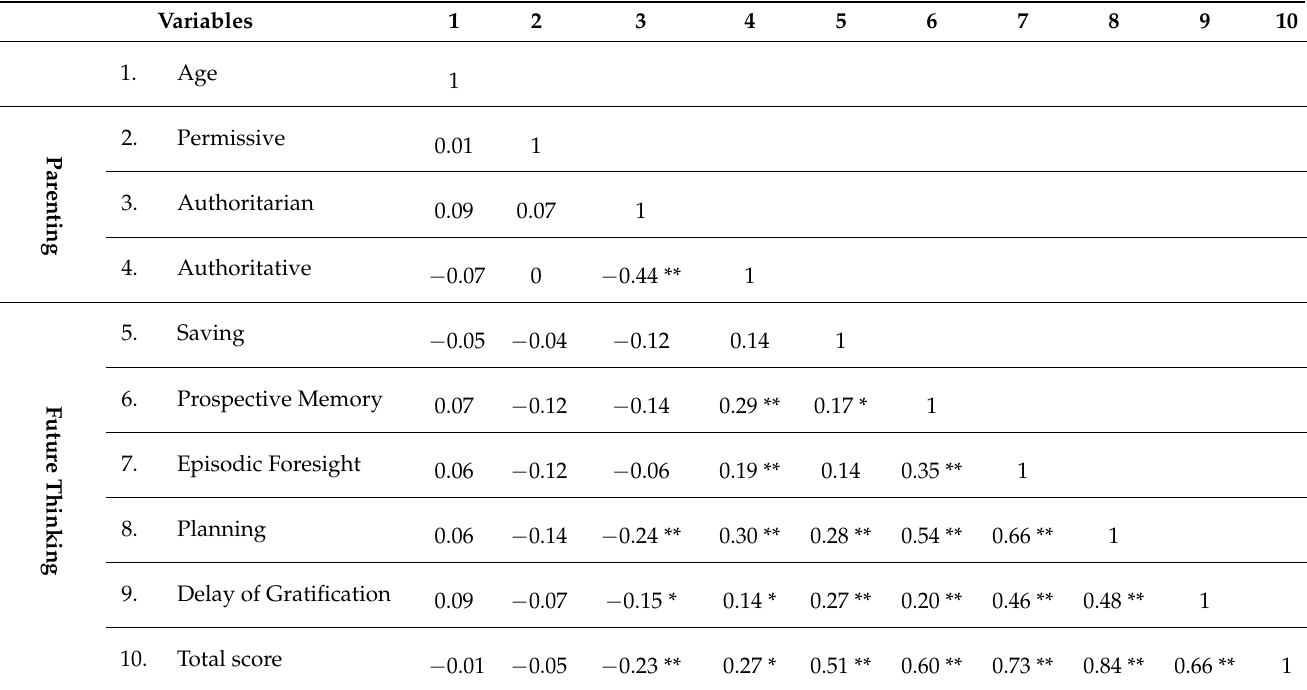
Table 2. Correlation coefficients between